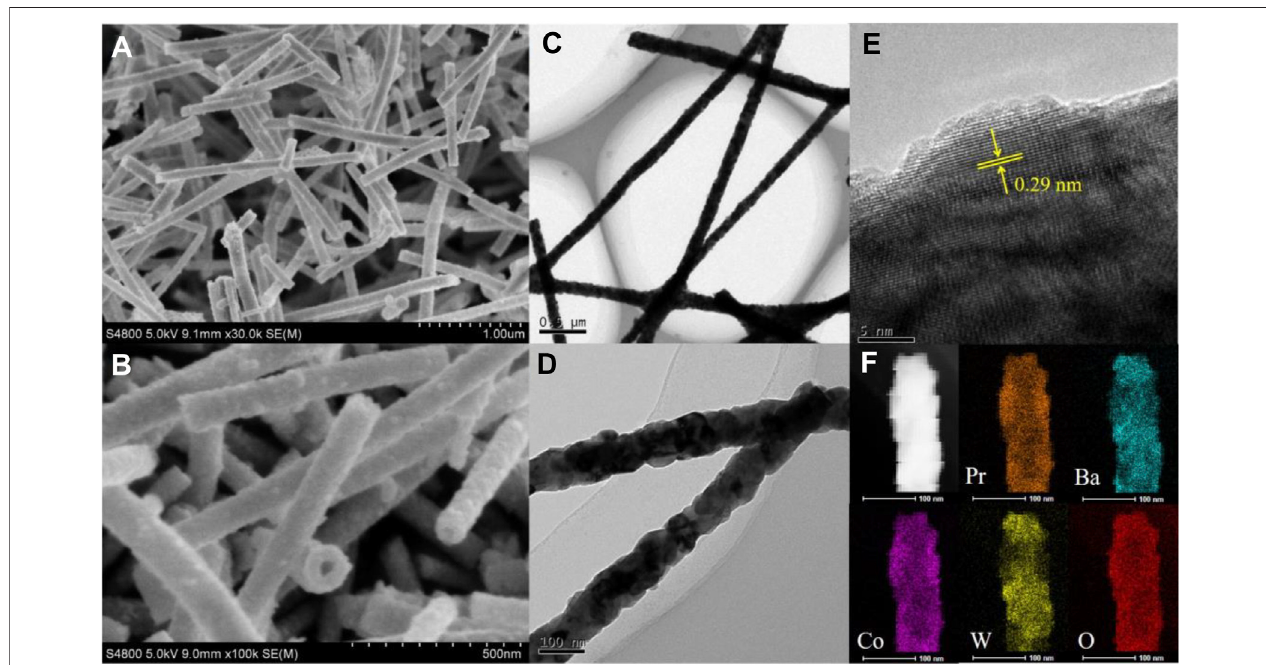
FIGURE 2 | (A, B) SEM. (C, D) TEM images. (E) corresponding SAED patterns and (F) STEM-EDX mapping of PrBaCo 0.8 W 0.2 .